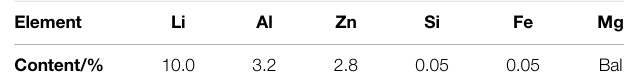
TABLE 1 | Chemical composition of LA103Z magnesium-lithium alloy (wt%). Element